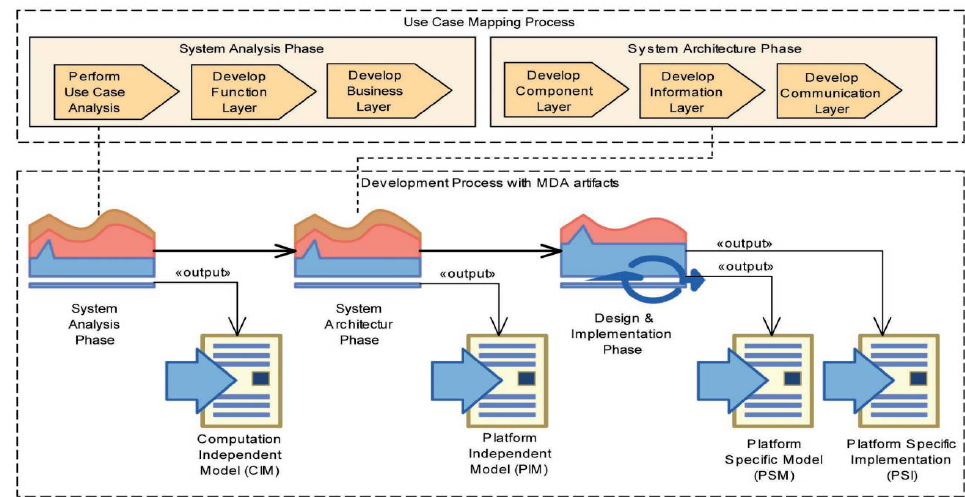
Figure 2. SGAM development process (CEN-CENELEC-ETSI, 2012).